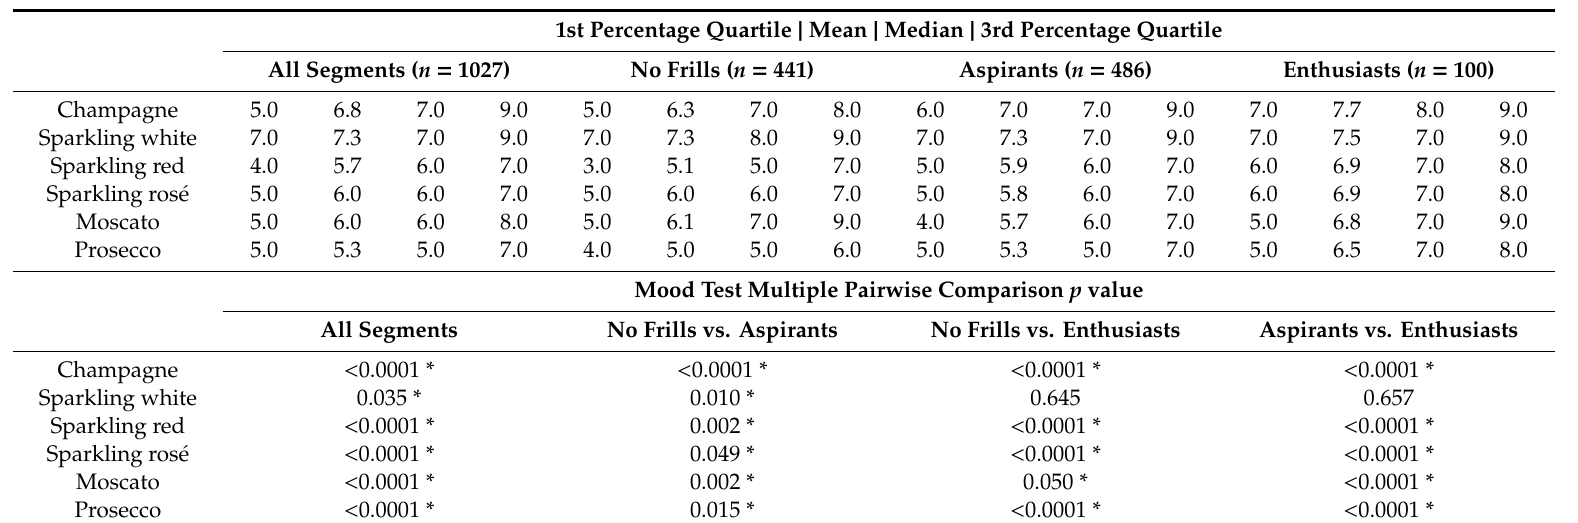
Table 4. Liking scores of Fine Wine Instrument consumer segments for di ff erent sparkling wine styles.